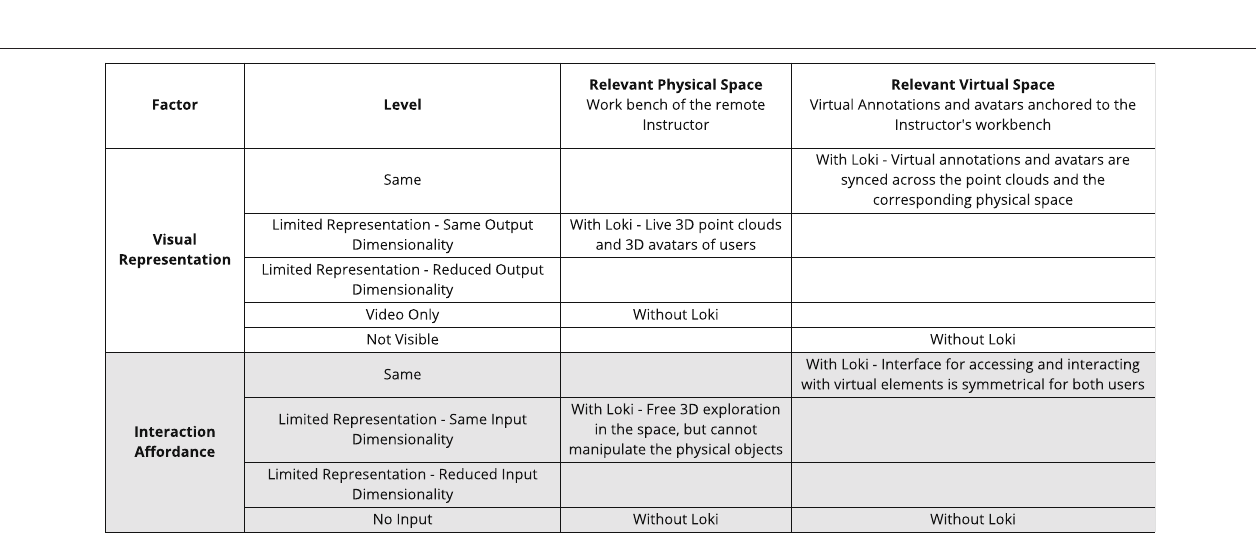
Frontiers in Virtual Reality |